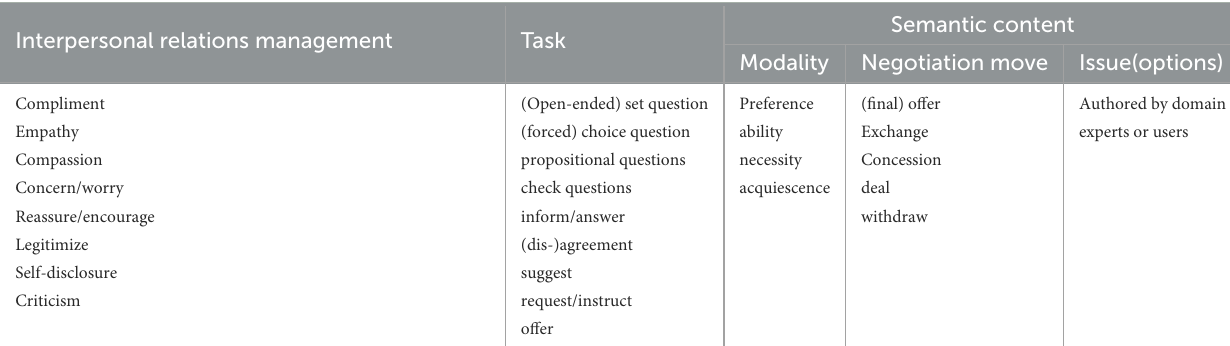
TABLE 5 Taxonomy of the agent’s